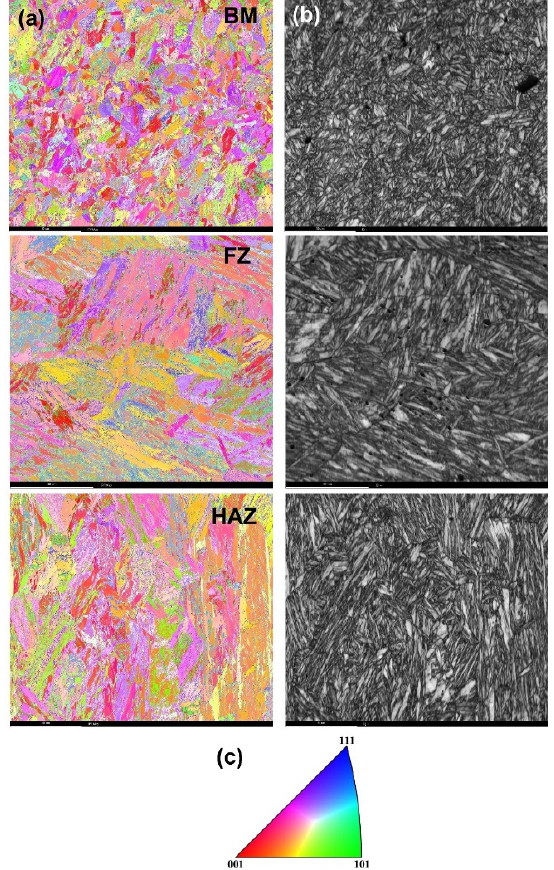
Figure 6. EBSD images EB-welded joint, S960QL steel; Top: BM, Middle: FZ, and Bottom: HAZ, ( a ) Inverse pole figures; ( b ) Image quality figures; ( c ) Inverse pole figure key.